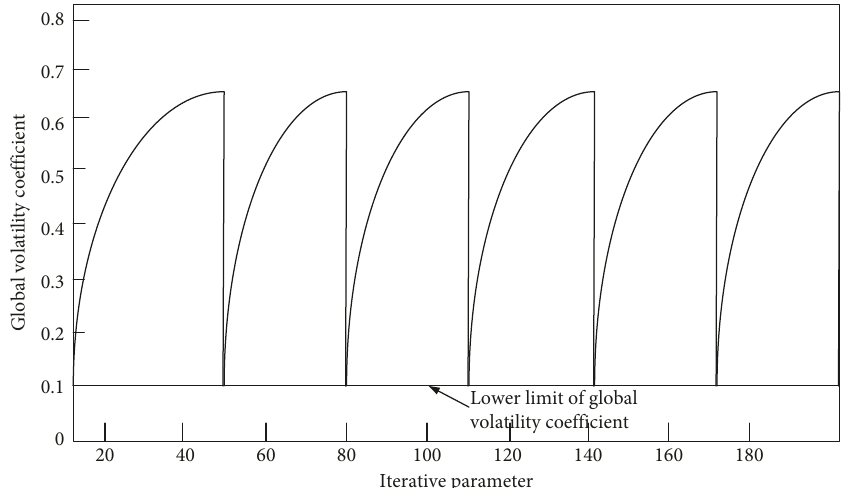
Figure 4: Evolution diagram of global volatilization coefficient.